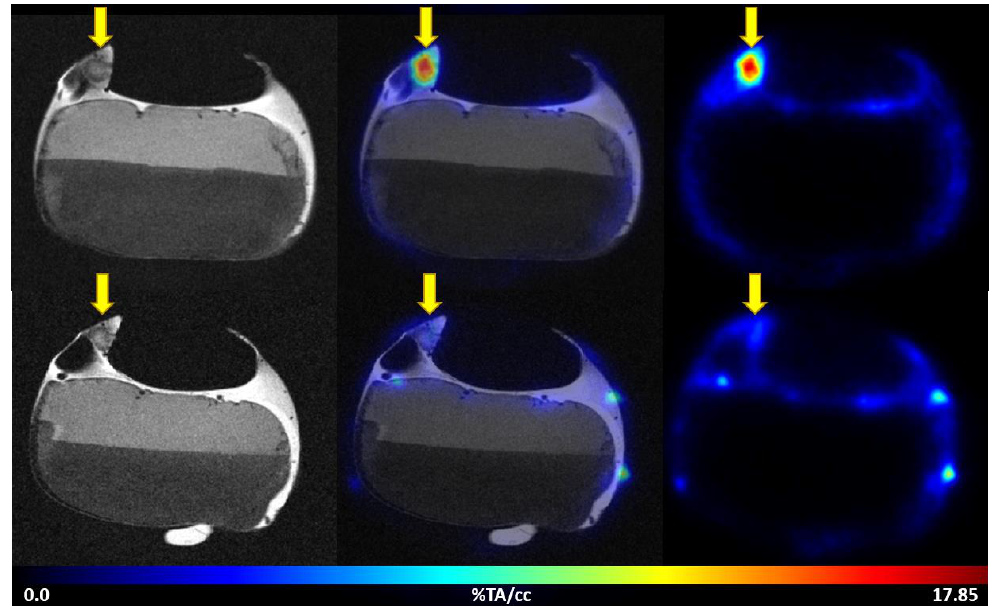
Figure 3. Representative images of [ 68 Ga]Ga-Pentixafor PET/MRI in the HT29 CAM-xenograft model. Upper row: baseline scan after i.v. injection of 3.50 MBq [ 68 Ga]Ga-Pentixafor (0.47 nmol peptide) on EDD15. Lower row: blocking (315 µg AMD3100/egg) of [ 68 Ga]Ga-Pentixafor uptake (7.57 MBq, 0.93 nmol peptide) in the same subject on the following day (EDD16). Left: T2-weighted TurboRARE images, right: [ 68 Ga]Ga-Pentixafor PET 60 min p.i., middle: fused PET/MRI (axial planes are shown). HT29 CAM-xenografts are marked with a yellow arrow.